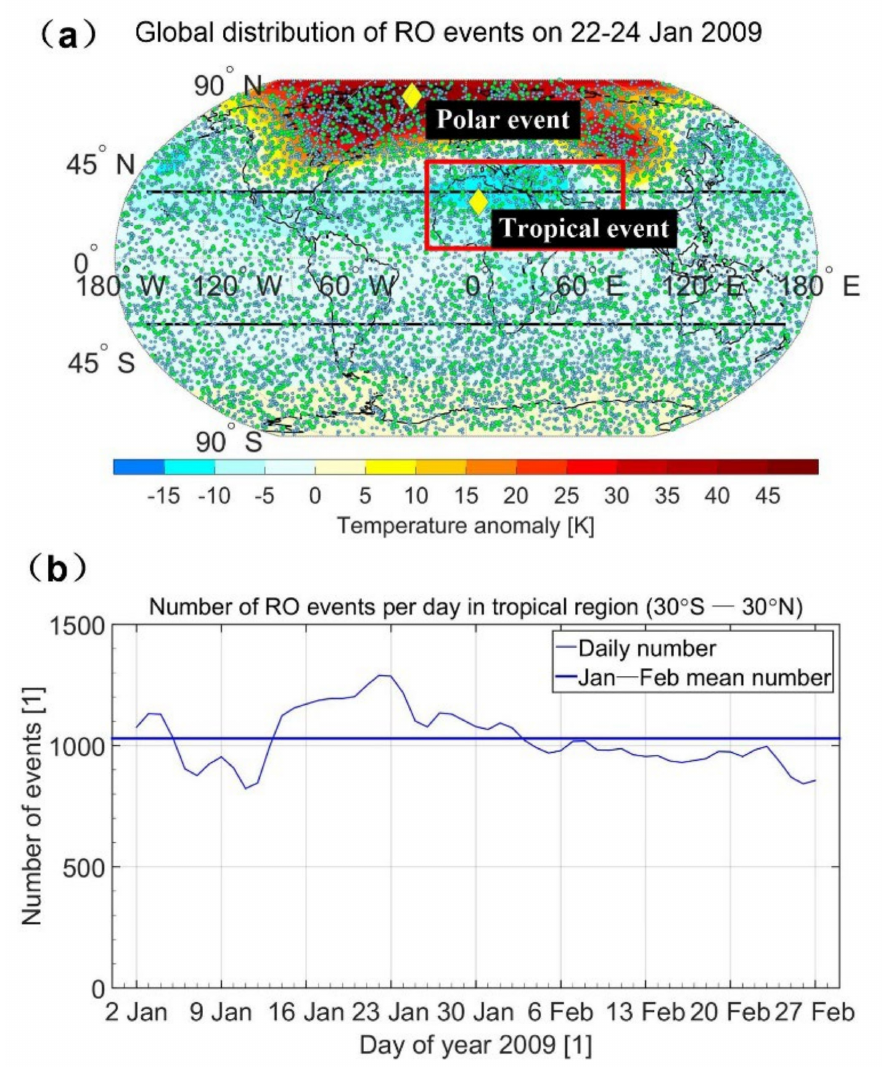
Figure 1. Panel ( a ): global distribution of OPSv5.6-processed high-quality RO events from COSMIC, MetOp, SAC-C, and GRACE missions (green dots) on 23 January 2009 (SSW onset date), as well as on the previous and next days (grey dots) that are used in our study below; the colors of contours indicate gridded mean temperature anomalies from 35–40 km over thresholds, and the red rectangle indicates regions where the largest tropical cooling events were observed on the onset day. Panel ( b ): numbers of RO events each day during January and February 2009 in tropical regions (30 ◦ S–30 ◦ N). The altitude layers with the largest temperature anomalies were regarded as the response altitude layers in our research. We can see from Figure 2, as well as the following Figure 3, that the response altitude layers of the three parameters in the tropical region were about 5 km higher than those in the polar region. This was probably related to the tropical ascent that elevates the response altitude layer